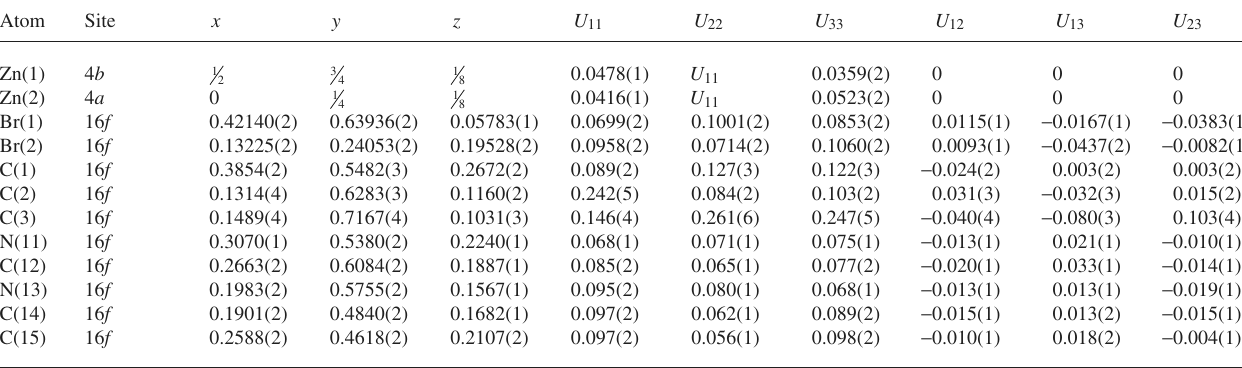
Table 3. Atomic coordinates and displacement parameters (in Å 2 )